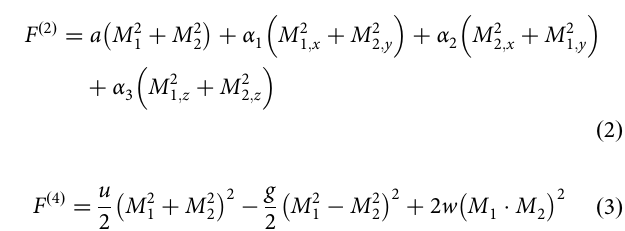
Fig. 4 Example neutron diffraction data showing magnetic Bragg re fl ections. Difference plots (black crosses) between neutron diffraction performed at temperatures above (red line) and below (blue line) magnetic transitions with magnetic Rietveld re fi nement plotted over difference (purple line). The two most intense magnetic peaks for each sample are labeled using the tetragonal unit cell notation. Representative examples of data for the three magnetic phases were selected. The peak at 5.7 Å in the x = 0.23 sample is from an impurity, La(OH) 3 . The peaks at ~3.4, and 4.6 Å in the x = 0.45 and x = 0.80 samples are from LaOH. The lanthanum hydroxides are estimated from re fi nements at ~1% by weight. Red tick marks are symmetry-allowed magnetic Bragg re fl energy expansion F M ð Þ ¼ F ð 2 Þ þ F ð 4 Þ :